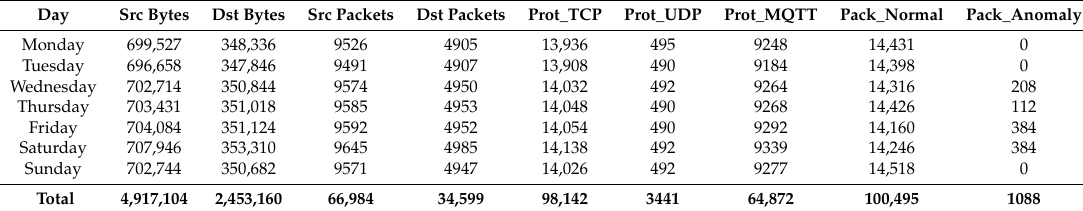
Table 5. Dataset statistics.